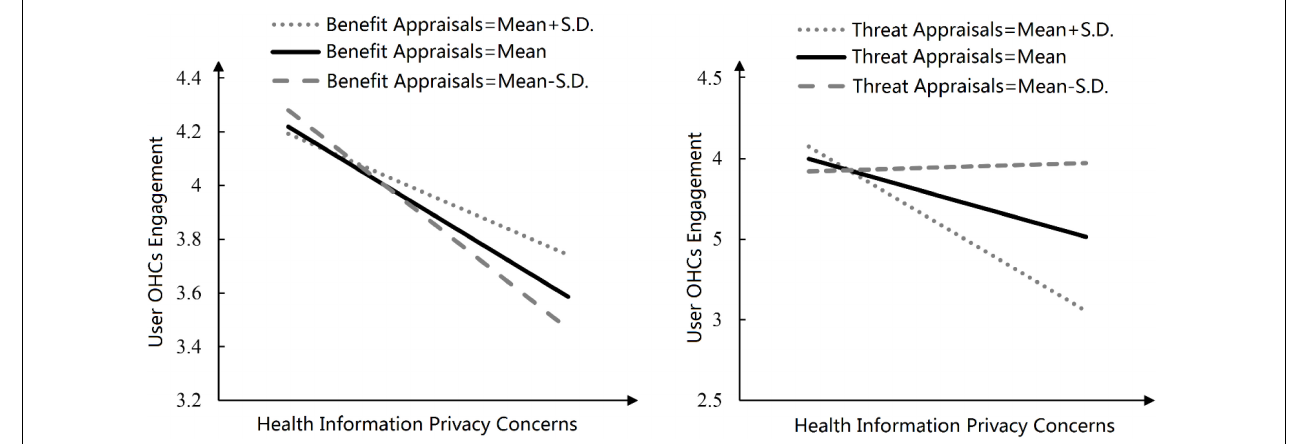
FIGURE 2 | Interaction